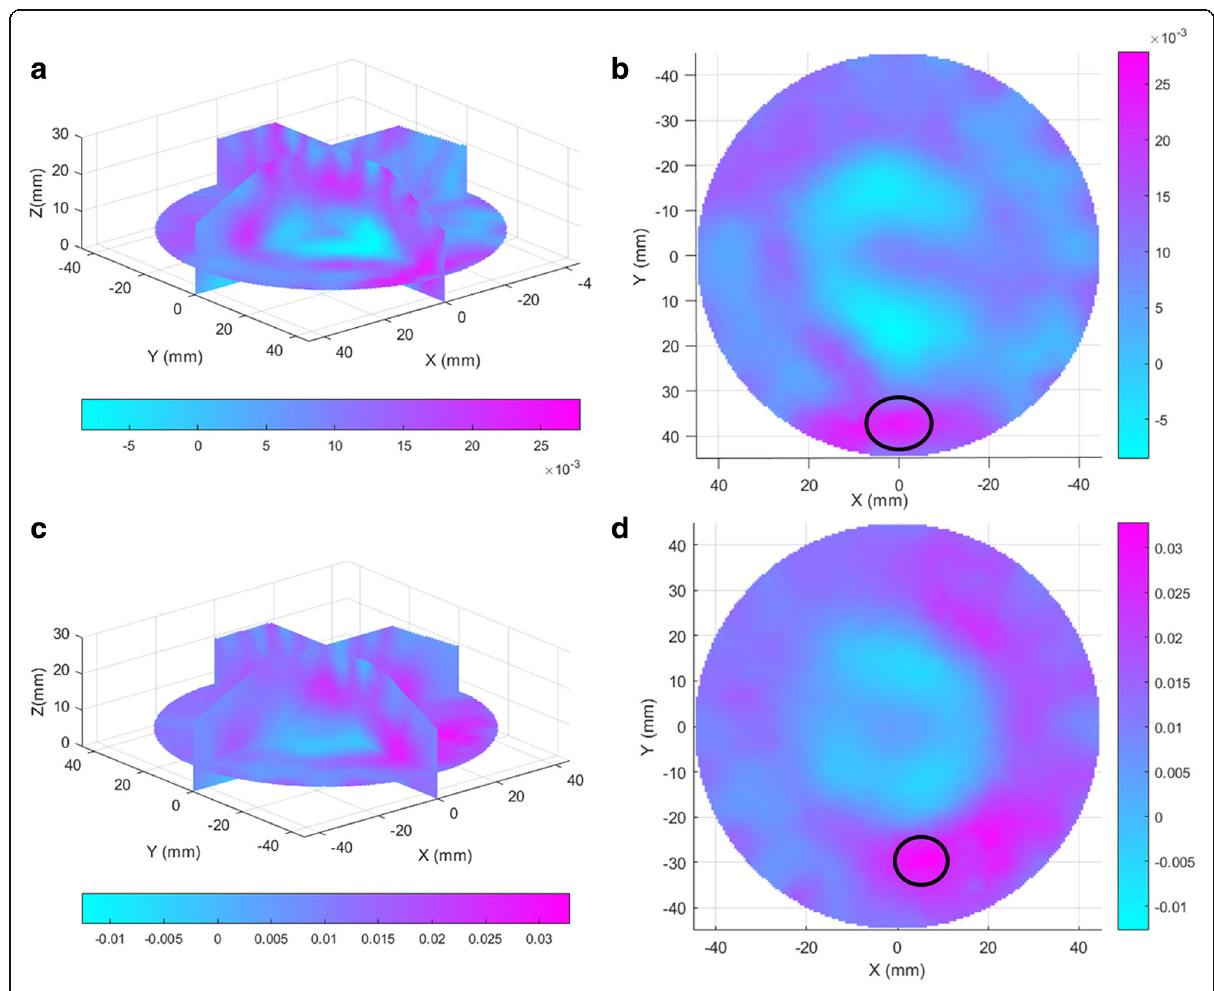
Fig. 1 Examples of diffuse optical tomography breast images. a 3D image of a benign breast tumor with a size of 3.0*1.3*1.3 , b 2D image sliced from Fig. 1a , c 3D image of a malignant breast tumor with a size of 2.4*1.3*1.2 , d 2D image sliced from Fig. 1c